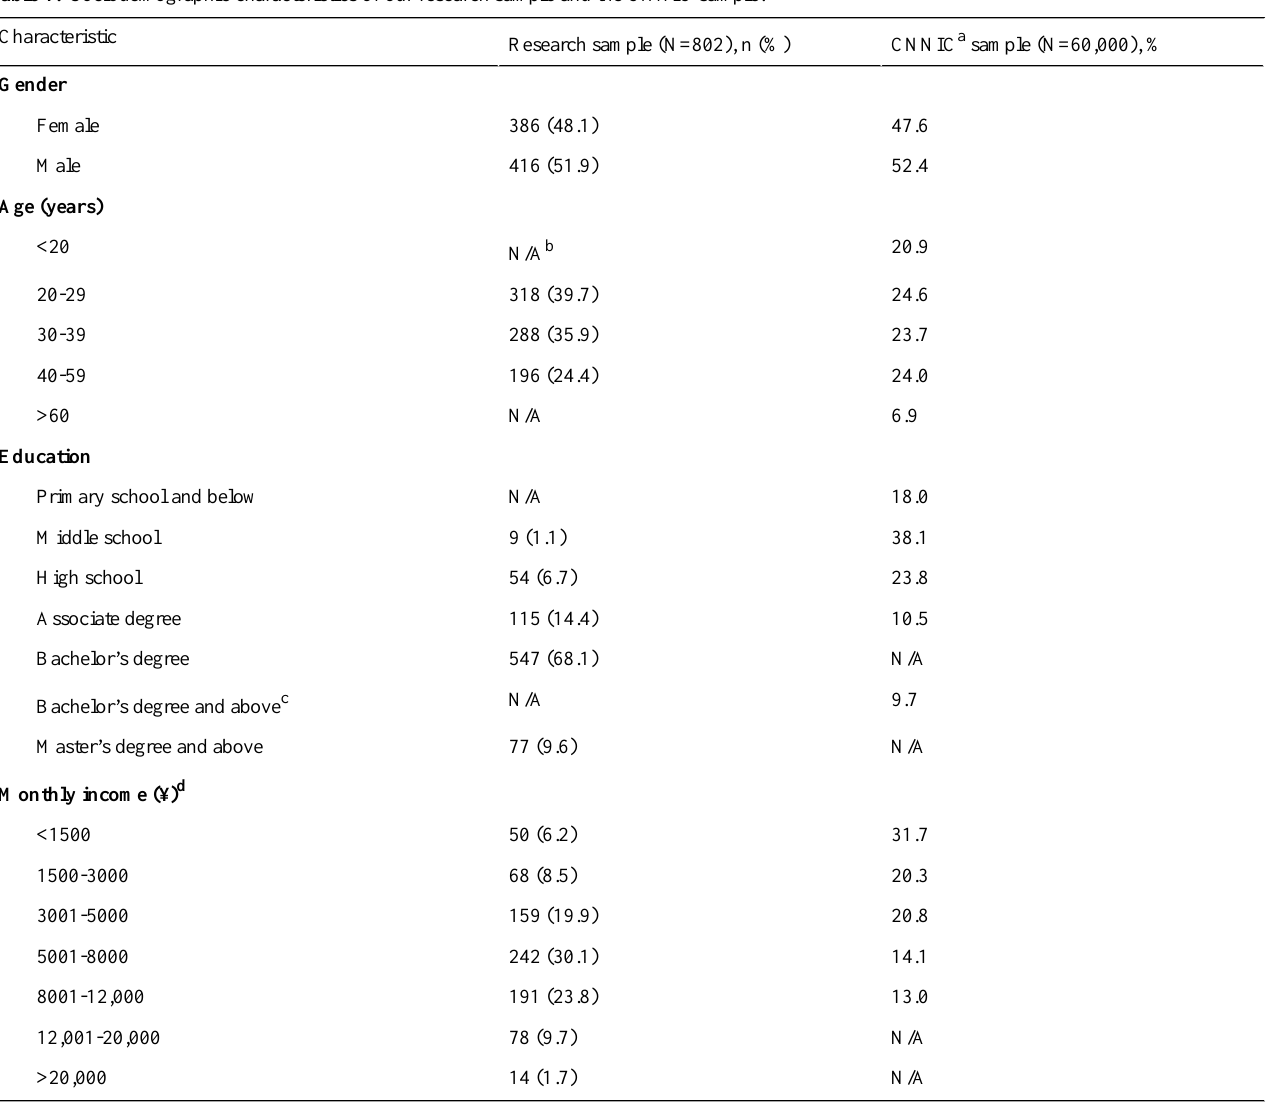
Table 1. Sociodemographic characteristics of our research sample and the CNNIC